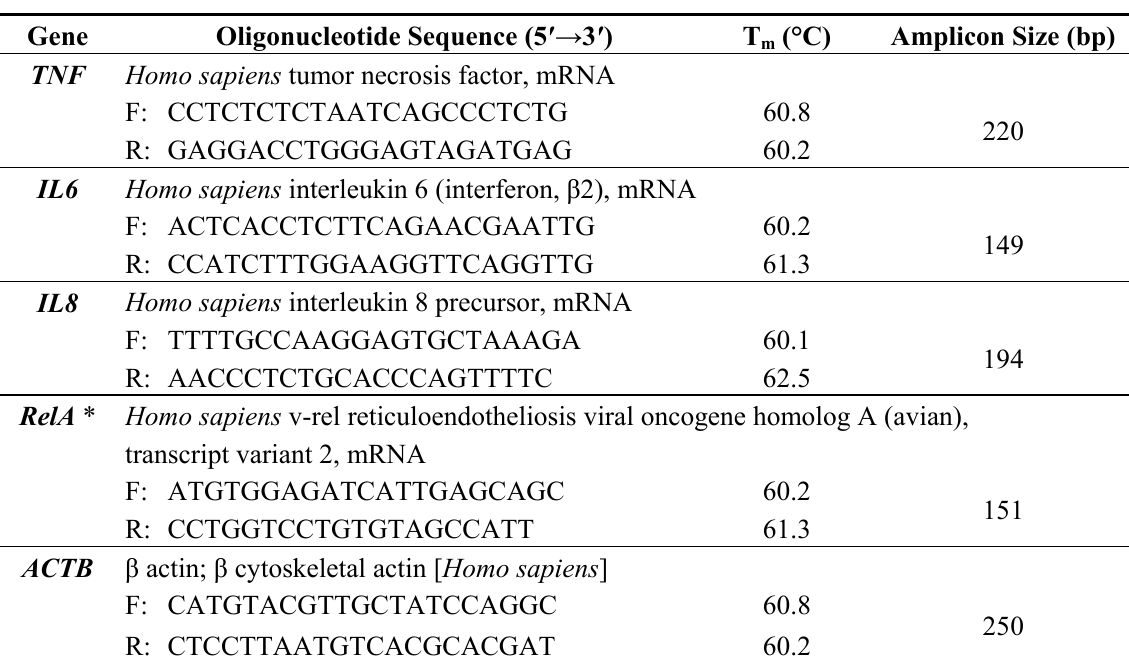
Table 1. Oligonucleotide primers used in this